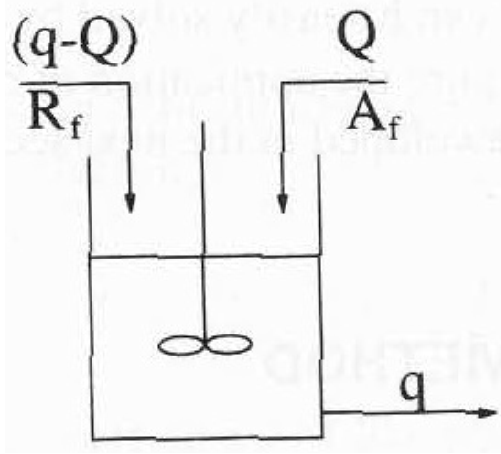
Figure 1. Continuous stirred-tank